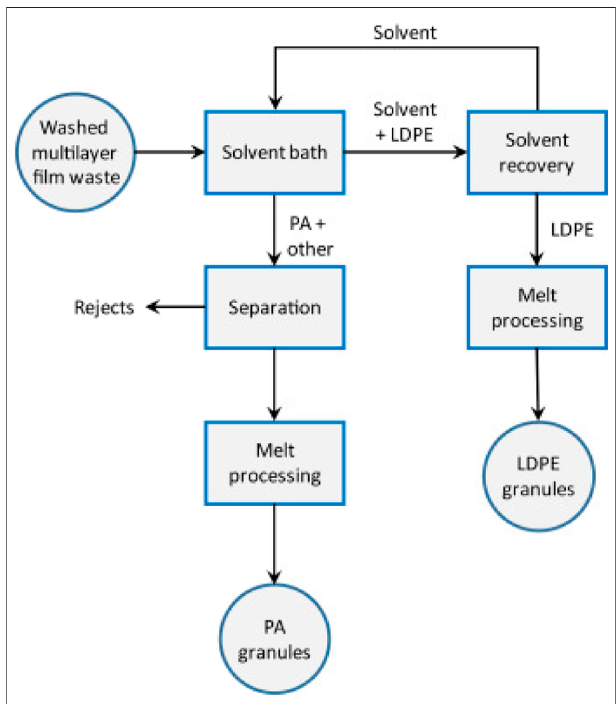
FIGURE 7 | A typical chemical recycling technique for waste plastic control (Pohjakallio et al., 2020).